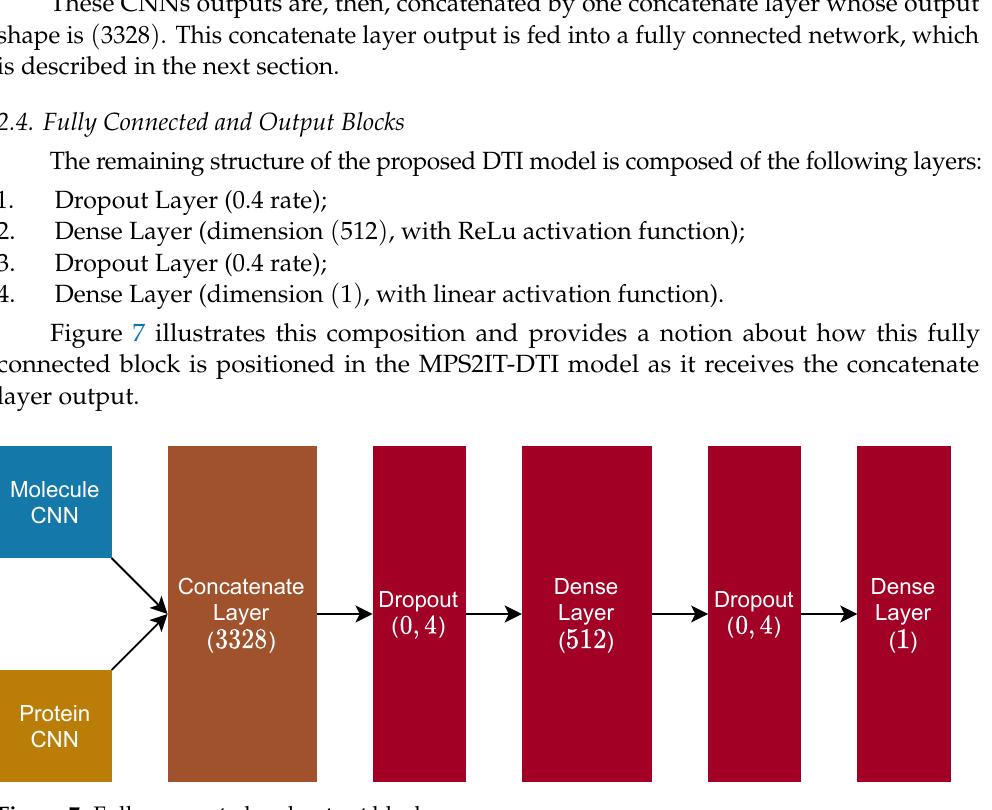
Figure 7. Fully connected and output